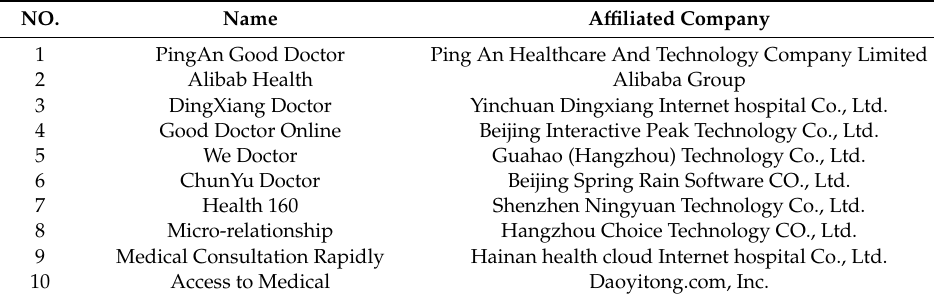
Table 1. 10 well-known M-medical APPs in the Chinese